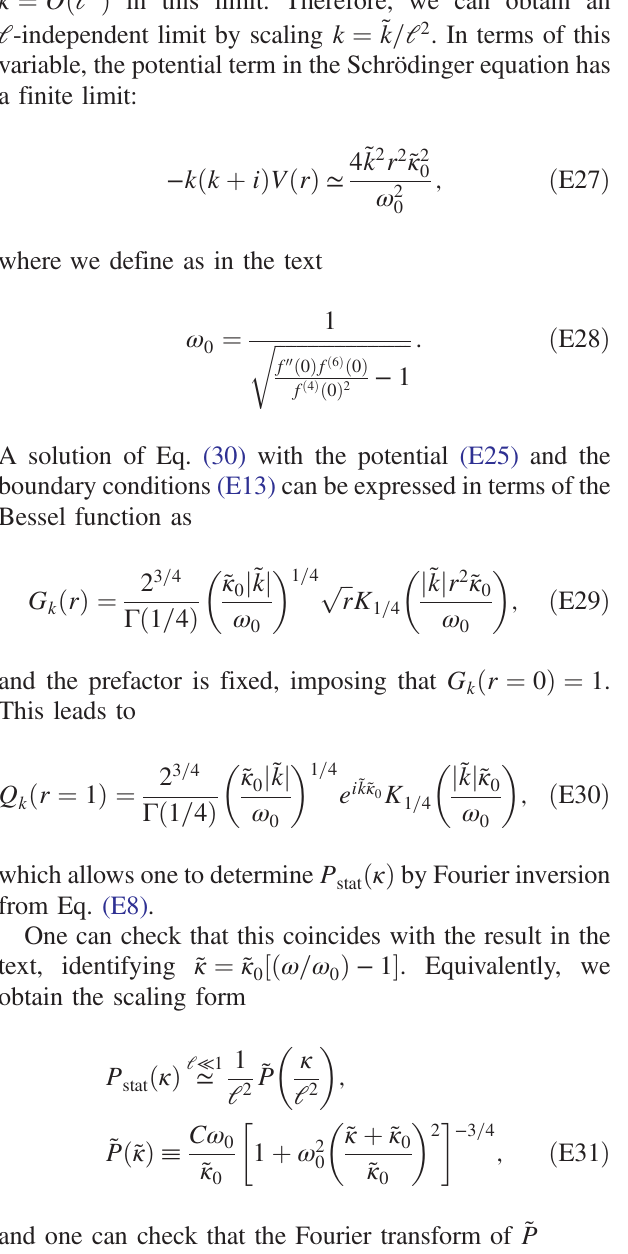
TABLE I. A few examples of noise correlation functions f ð x